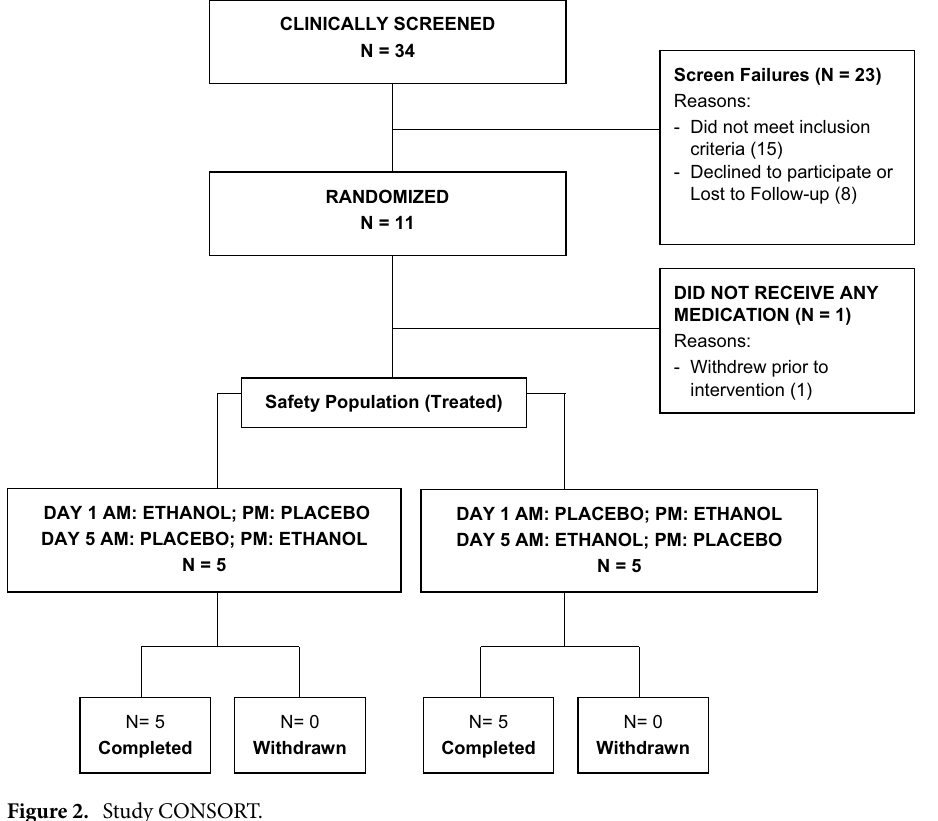
Figure 2. Study CONSORT.